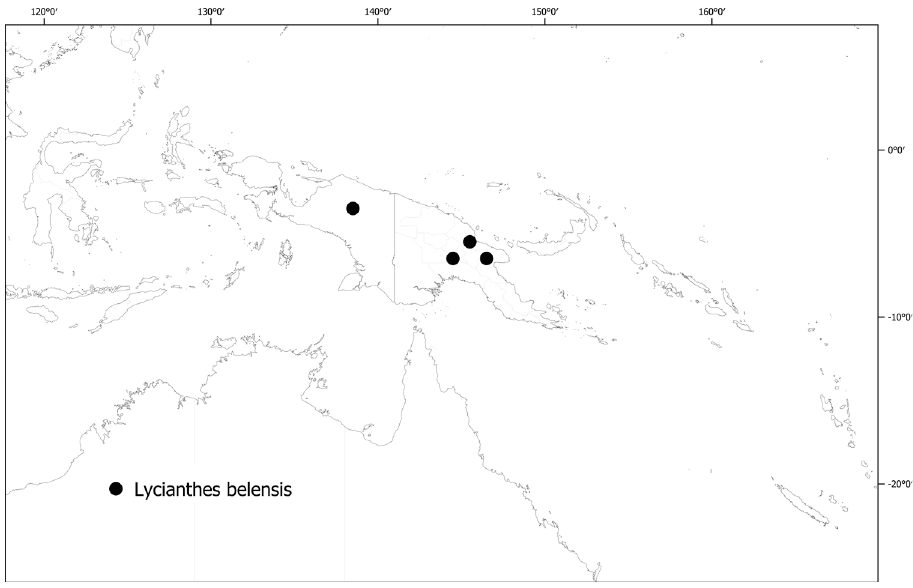
Figure 9. Distribution of Lycianthes belensis